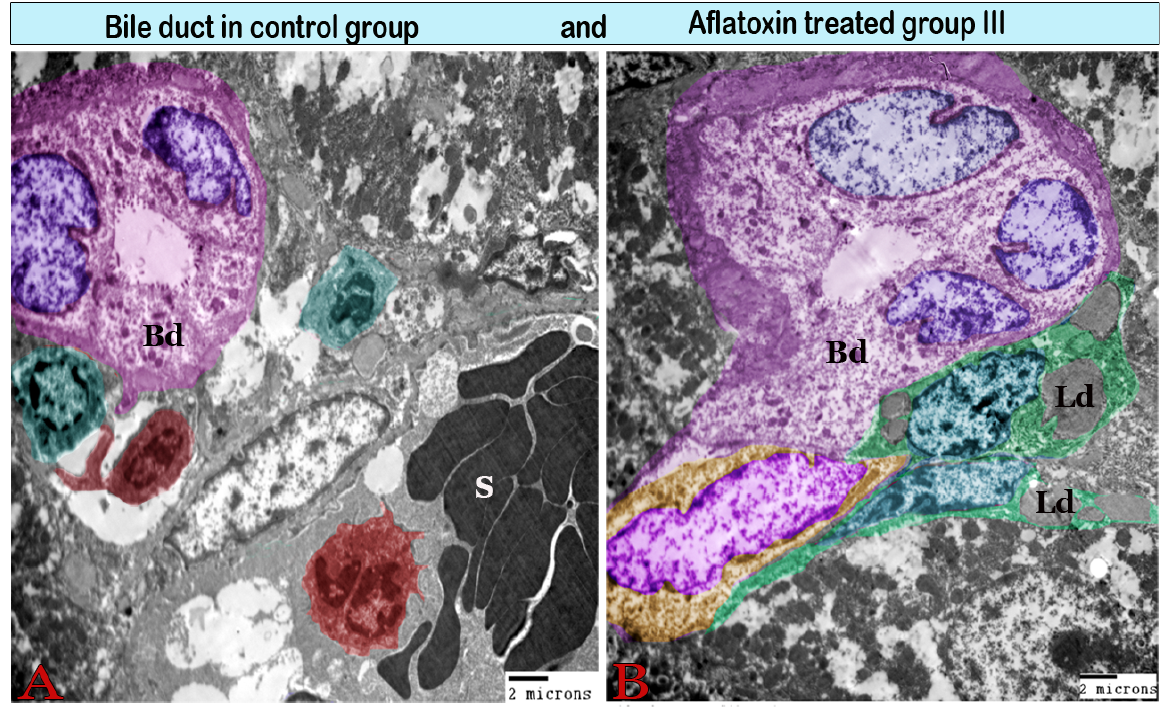
Figure 9. Digital colored transmission electron microscopy micrographs of a cross section of a bile duct (Bd) from the control group (A) and aflatoxin B1-treated group III (B). ( A ) Normal interlobular bile duct surrounded by Kupffer cells (red) and pit cells (green); note the lumen (L) and bile duct epithelium (E). ( B ) Large interlobular bile duct encircled by a thick fibrous sheath. It is surrounded by Ito cells (green), which are loaded with large lipid droplets (Ld).